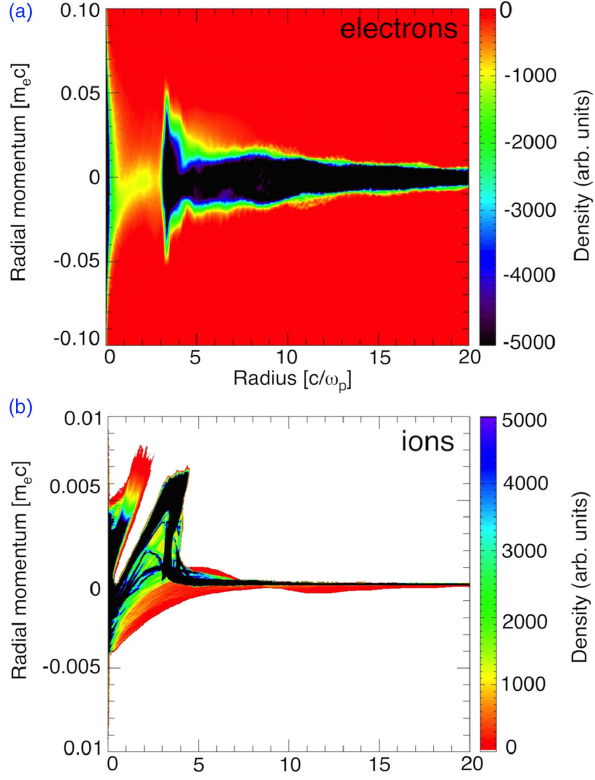
) pe c ω e − 1 ) at the electron e pe p ffiffiffiffiffiffiffiffiffiffiffiffiffiffiffiffiffiffiffiffiffi ¼ h T i =m k . Since s B e i FIG. 7. Radial phase-space snapshots of the electron and ion − r radial momentum phase density in Fig. 2. (a) Electron p r space showing the accumulation of thermalized electrons within − r radial momentum phase space the ion soliton. (b) Ion p r showing the on-axis and ion-wake edge ion